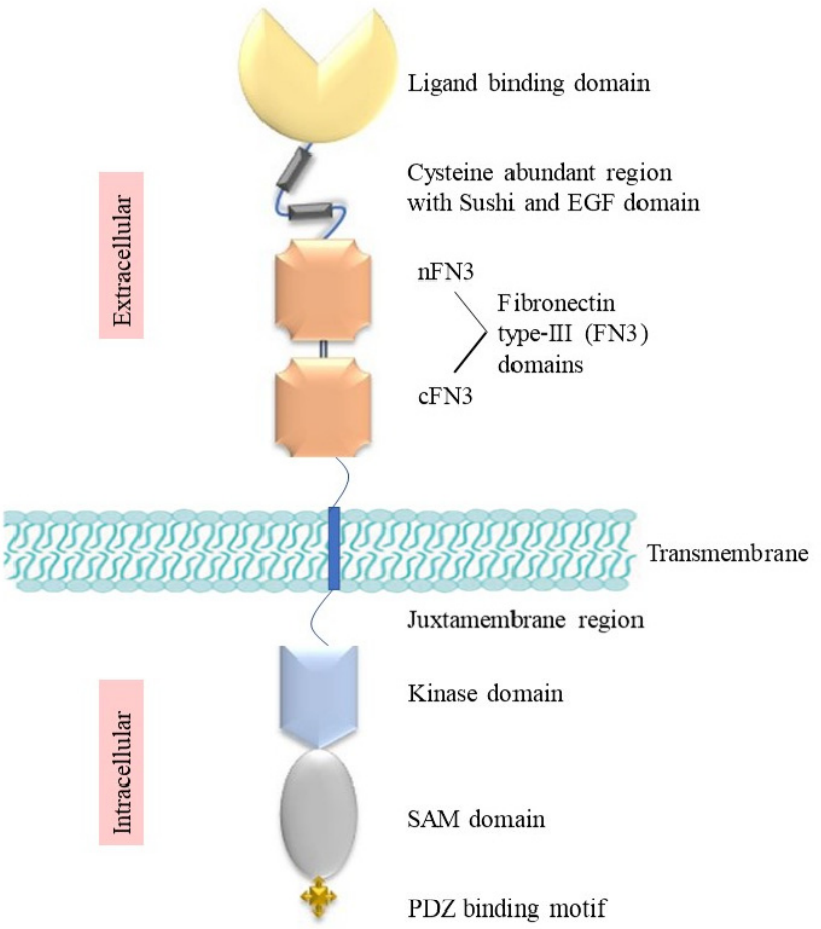
Figure 1. Structure of Eph receptors. Eph receptors are multidomain transmembrane proteins. The extracellular region consists of a ligand-binding domain (LBD) that binds to ephrin ligands on adjacent cells, a cysteine-rich domain (CRD) composed of a sushi and EGF domain, and two fibronectin III domains located C-terminally to the LBD. A juxtamembrane (JM) region, a kinase domain (KD), a SAM domain, and a C-terminal PDZ-domain-binding motif make up the Eph receptor cytoplasmic domain.